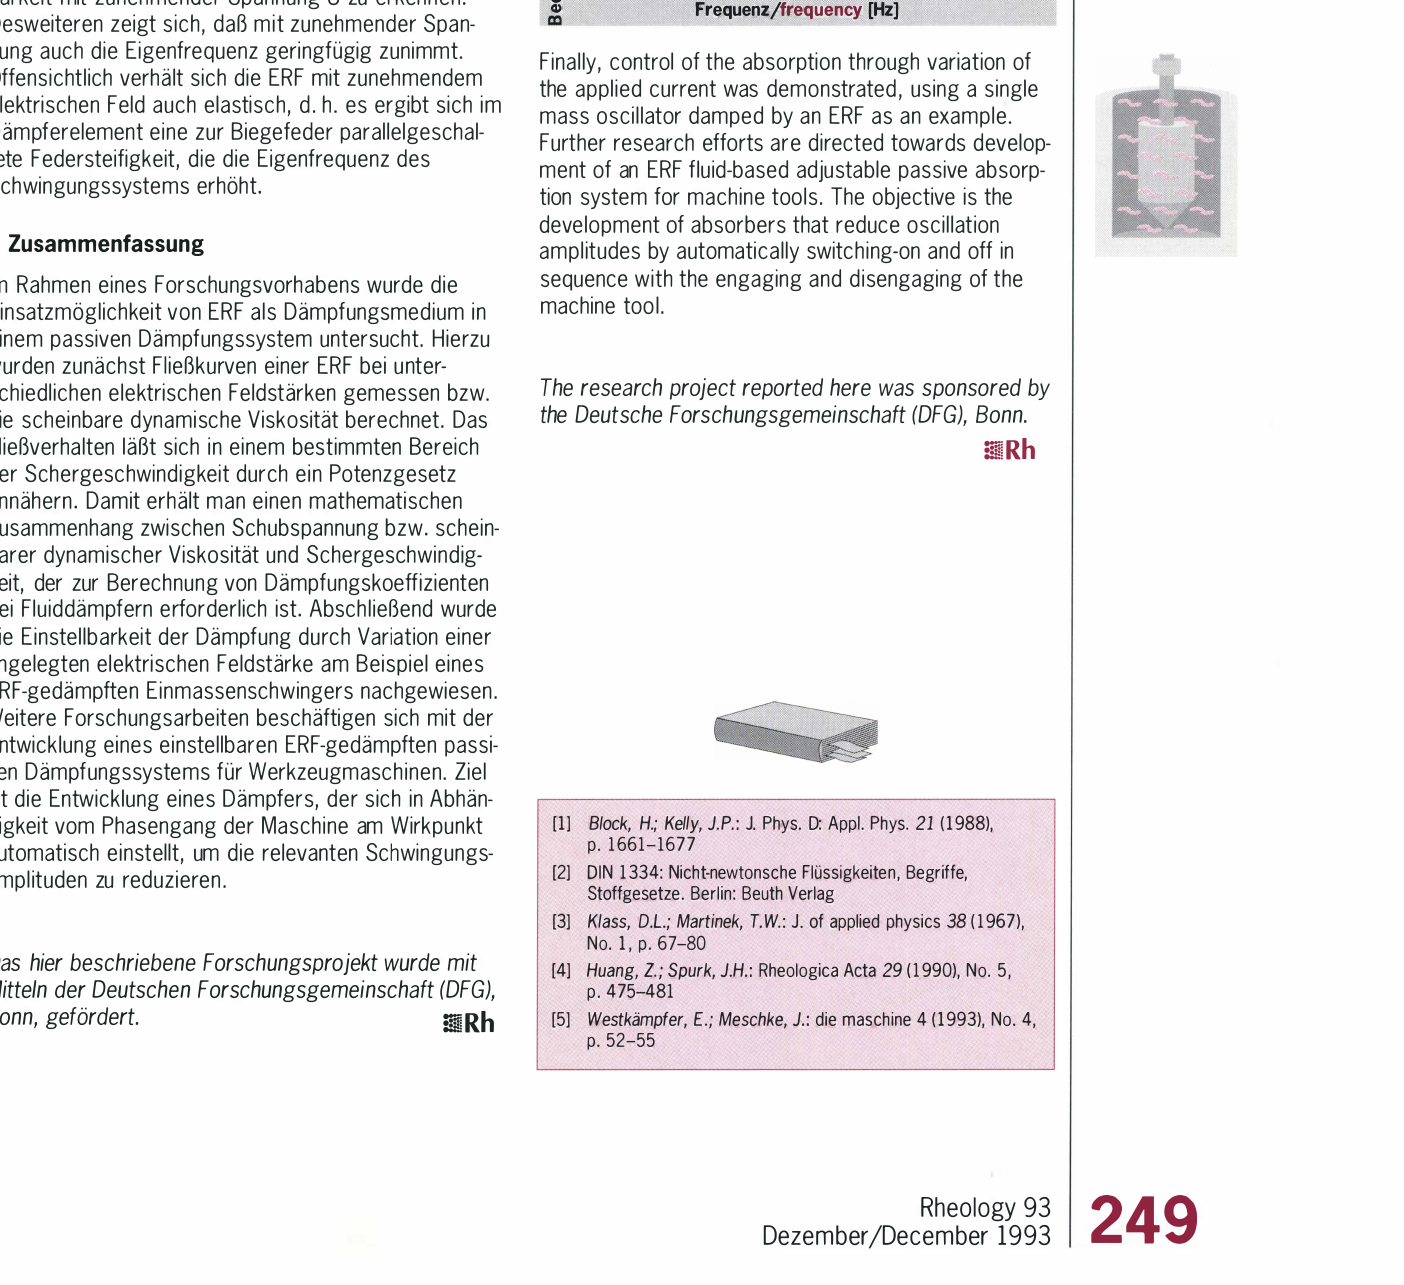
Fig. 9: Accelerability frequency processes of an ERF-based single mass oscillator at various values of the imposed electric